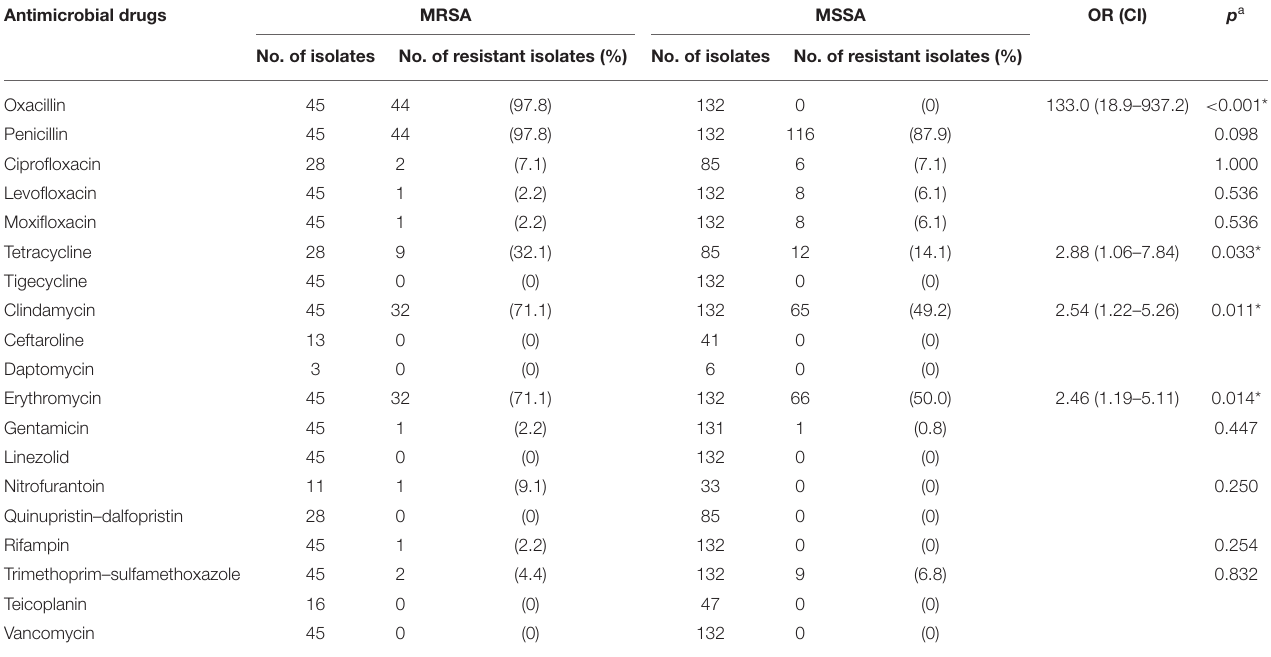
TABLE 2 | Antimicrobial susceptibility testing results among MRSA and MSSA. Antimicrobial drugs MRSA MSSA